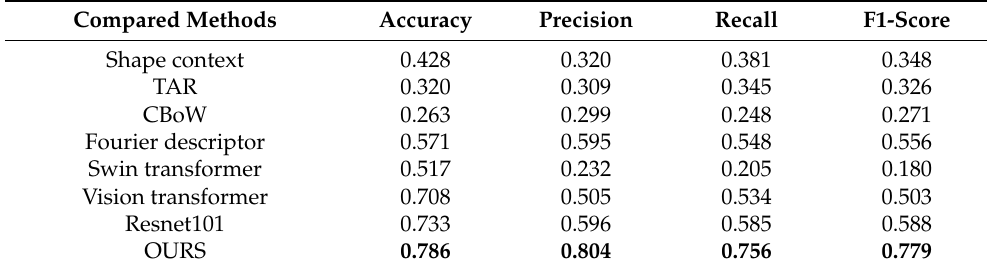
Table 6. Lenke classification results for the representative and latest methods. Bold means the best. Compared